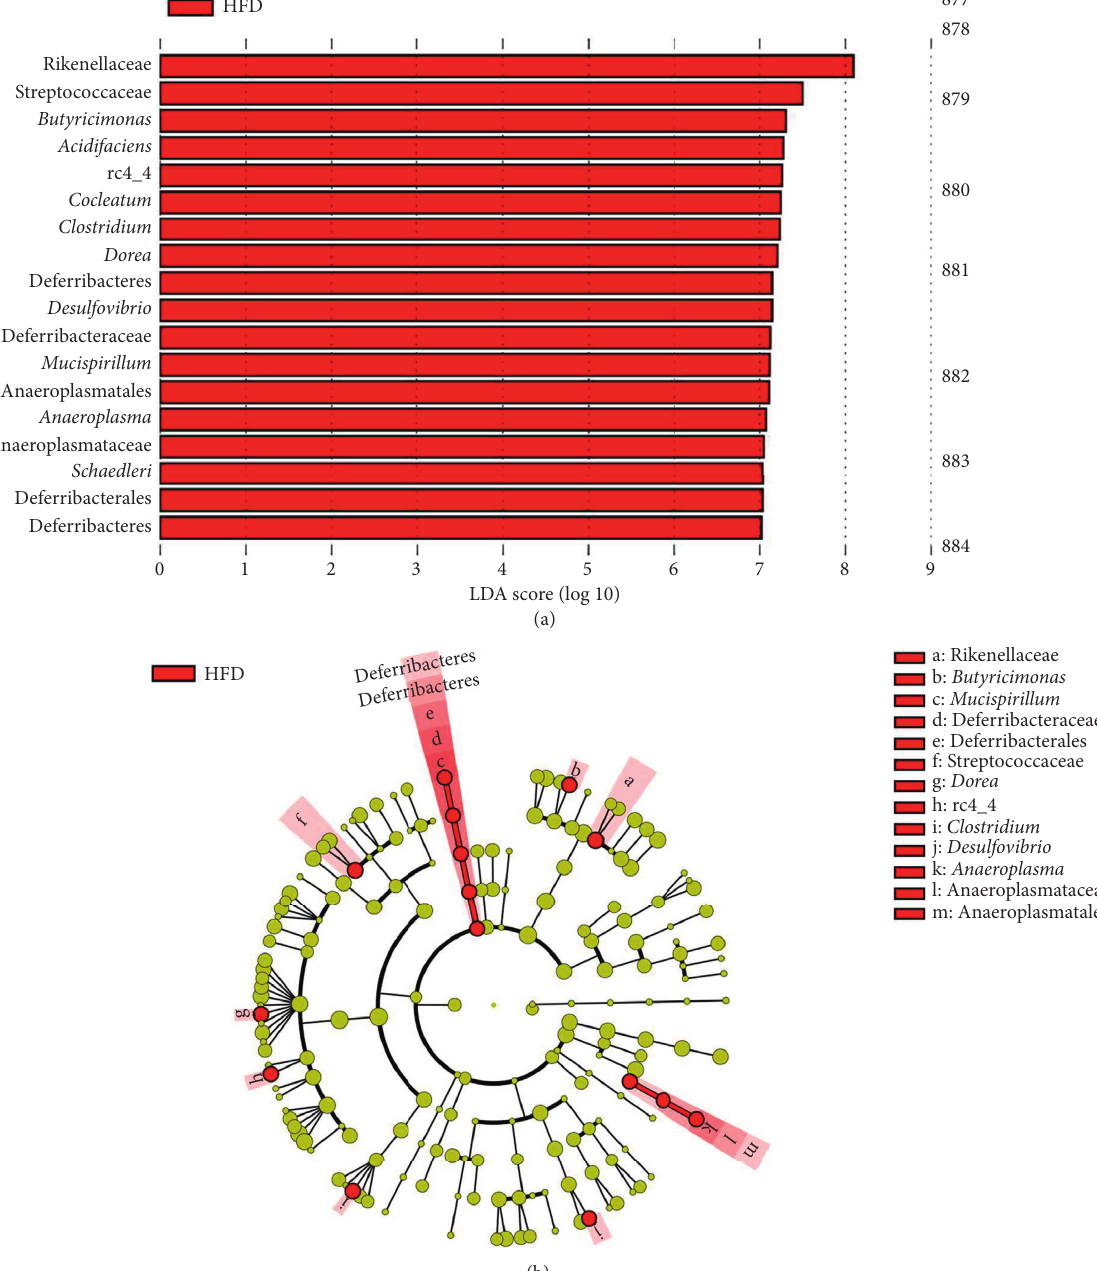
Figure 5: Differently abundant taxa after 10 weeks of either Chow or HFD. (a) Linear discriminate analysis of effect size (LEfSe) results depicting different microbial taxonomic signatures in fecal samples collected from male Sprague-Dawley rats fed an HFD ( n � 5-6/group) at week 10 in comparison to Chow-fed samples at week 10. Fecal samples collected from HFD-fed rats were more abundant in the following phyla: Bacteroidetes, Firmicutes, Clostridium , Deferribacteres, Proteobacteria, and Tenericutes (LDA > 2.0:18). No other differences were detected. (b) Cladogram depicting differentially abundant microbial taxa in stool samples collected from male Sprague-Dawley rats fed a high-fat diet ( n � 5-6) for 10 weeks. Microbial taxa enriched in HFD rats are shown in